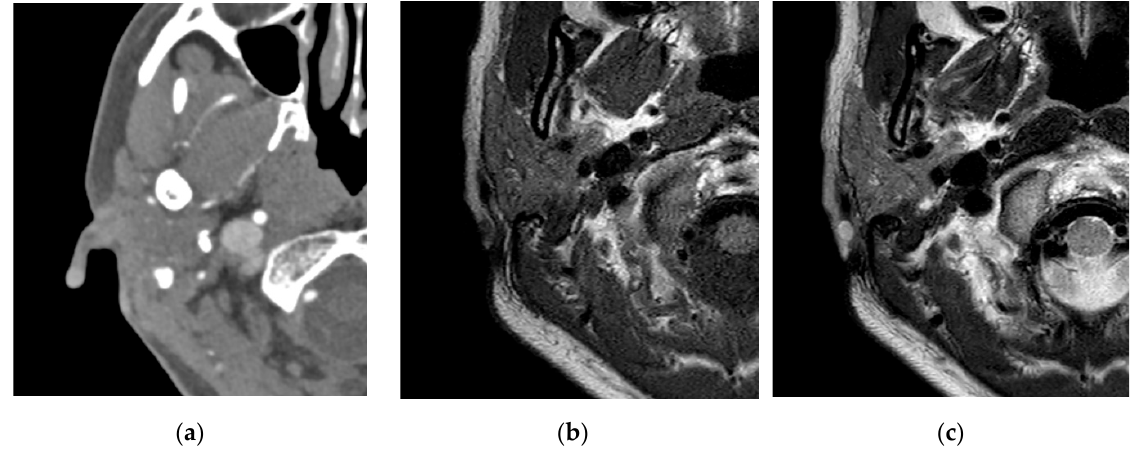
Figure 1. Venous malformation is a congenital malformation of the vascular venous system [1]. It can occur anywhere in the body, but is most common in the head, neck, and extremities [2]. Venous malformation in the auricle is rare and no cases have been reported. A 44-year-old woman visited the otorhinolaryngologic clinic for a mass in the right auricle that had been present for five years and had shown no recent changes in size. She had no symptoms such as pain or bleeding. On phys- ical examination, a blue, soft cystic mass about 0.5 × 0.5 cm in size was observed at the lower helix of the right auricle.